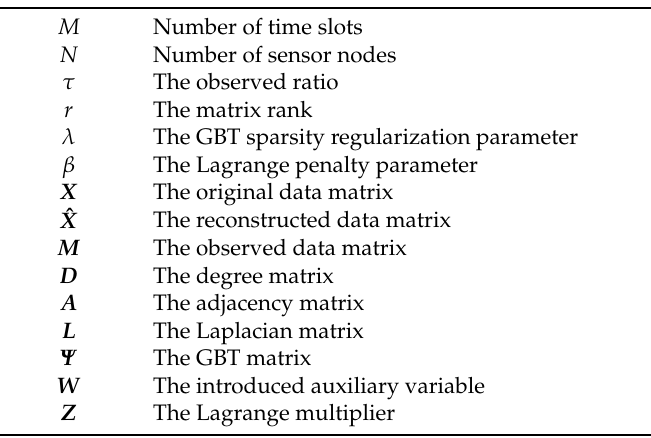
Table 1. Summary of